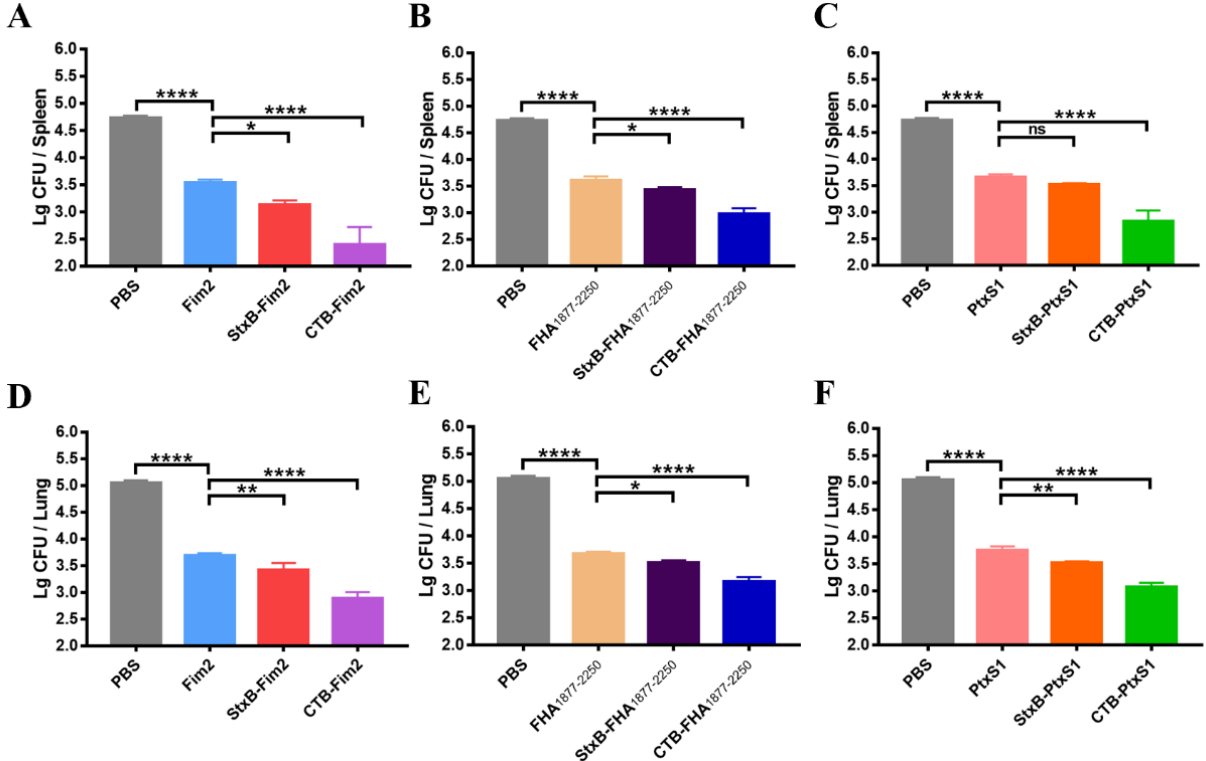
Figure 4. Bacterial loads in the spleens and lungs of immunized mice. ( A ) Bacterial loads in the spleens of mice from the PBS, Fim2, StxB-Fim2, and CTB-Fim2 groups. ( B ) Bacterial loads in the spleens of mice from the PBS, FHA 1877–2250 , StxB-FHA 1877–2250 , and CTB-FHA 1877–2250 groups. ( C ) Bacterial loads in the spleens of mice from the PBS, PtxS1, StxB-PtxS1, and CTB-PtxS1 groups. ( D ) Bacterial loads in the lungs of mice from the PBS, Fim2, StxB-Fim2, and CTB-Fim2 groups. ( E ) Bacterial loads in the lungs of mice from the PBS, FHA 1877–2250 , StxB-FHA 1877–2250 , and CTB-FHA 1877–2250 groups. ( F ) Bacterial loads in the lungs of mice from the PBS, PtxS1, StxB-PtxS1, and CTB-PtxS1 groups. Data are expressed as the means ± SD and were analyzed by a one-way ANOVA with Dunnett’s multiple-comparison test for the